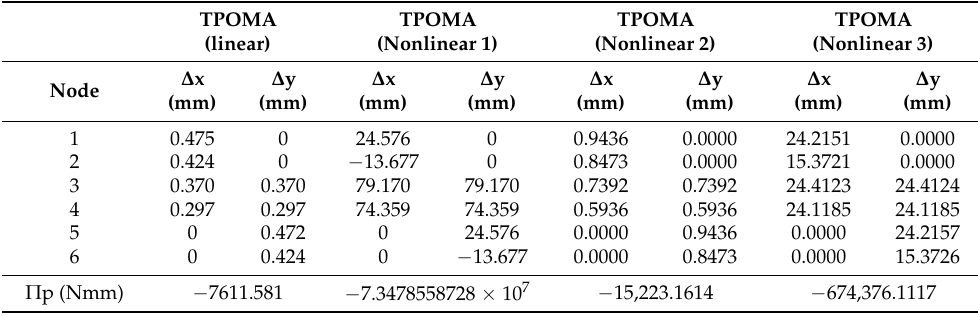
Table 3. Optimum solutions for the system with 4 members-6 nodes (adaptive harmony search (AHS)).